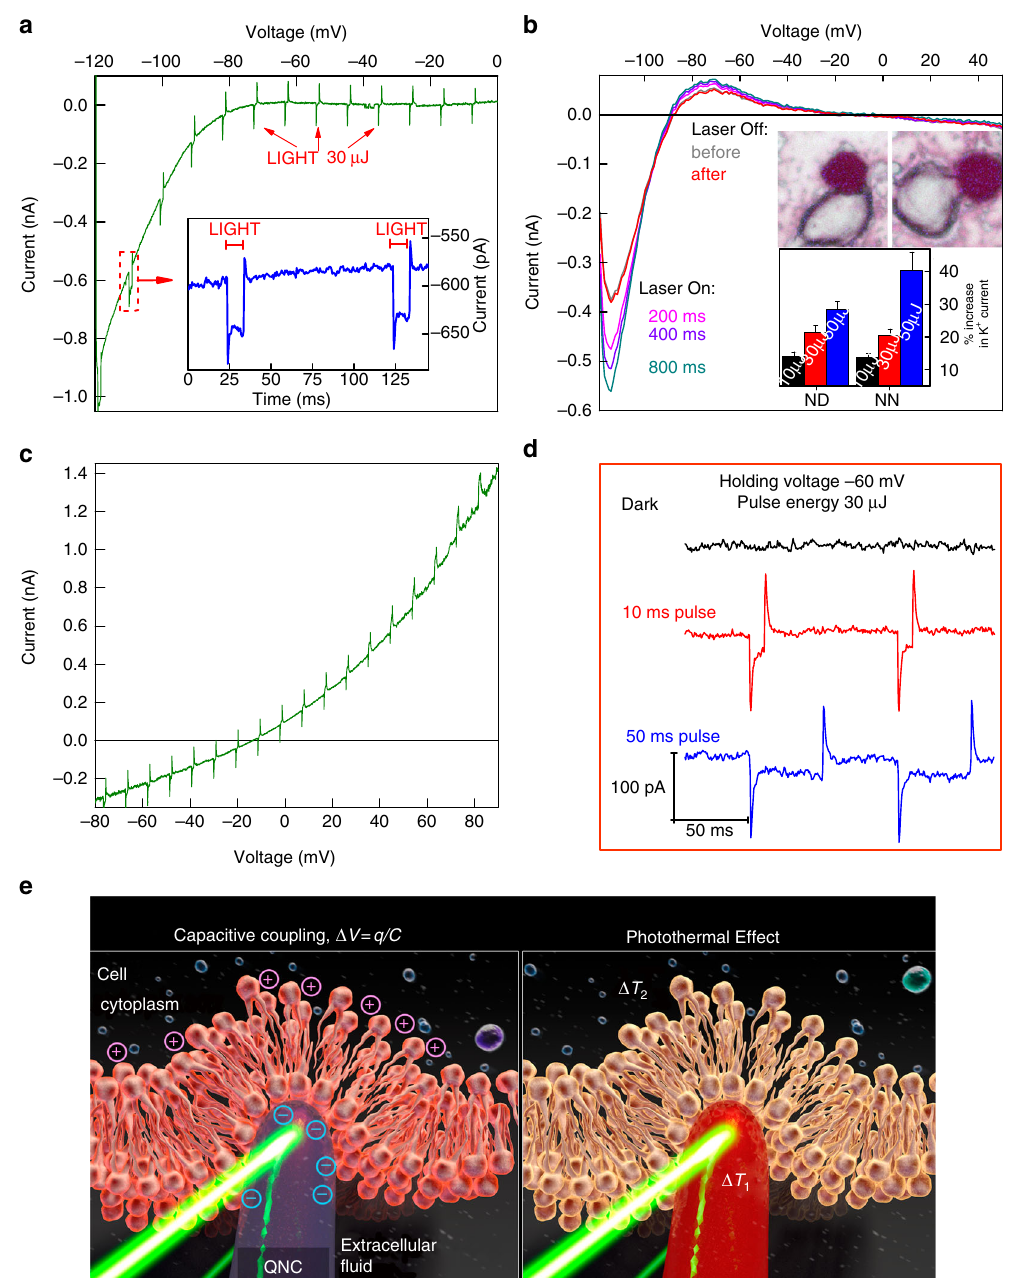
Fig. 7 Hedgehog-mediated photostimulation of ion channels. a Reversible photostimulation of the K + inward recti fi er channel with 10 ms light pulses in an RBL cell grown on a 10- µ m-size nanoneedle hedgehog apparent in voltage – clamp measurements in whole-cell con fi guration. Rapid ( < 1 ms time scale) light- induced depolarising currents are visible over the entire voltage sweep range, however only where the K + inward recti fi er channel is open ( V < − 80 mV) are there photoinduced increases (+30%) in K + inward current. The inset shows the effects of light pulses, at a holding potential of − 110 mV with the depolarising current spikes and a plateau region of K + current increase, the latter attributed to local photothermal heating and faster ion diffusion. b The K + recti fi er in an RBL cell on hedgehog measured using CW illumination over 1 s, 5 mW/mm 2 . The current – voltage characteristic remains the same, only the peak value of K + current increases reversibly with illumination. This is consistent with photothermal heating raising the local temperature of the cell, increasing the current of ions through the open channels. The inset shows statistics for photoinduced K + in fl ux increase percentage (K + recti fi er) of the illuminated RBL cells growing on nanoneedle-type and nanodagger-type hedgehogs. Error bars represent the standard error of the mean ( n = 11 – 14). The photomicrograph shows how cells in contact with hedgehogs appear under the microscope. c Current – voltage relationship of cation current in temperature-sensitive TRPV1 channels overexpressed in HEK cells on hedgehogs. Depolarising current spikes are visible throughout the whole trace while increases in cation current are apparent in voltage ranges where the channel is open. d HEK cell with TRPV1 give rapid and reversible photoinduced stimulation of cation in fl ux when measured at the cell resting potential, − 60 mV. e Schematic illustration of the mechanisms possible at nanocrystal/cell interfaces. Photocapacitive membrane depolarisation can occur on a short time-scale ( left ) and rapid photothermal changes can lead to capacitive modulation at short time scales, while increases in through-channel conductance due to localised photothermal heating ( right ) can be observed on time scales from 10 ms up to 1000